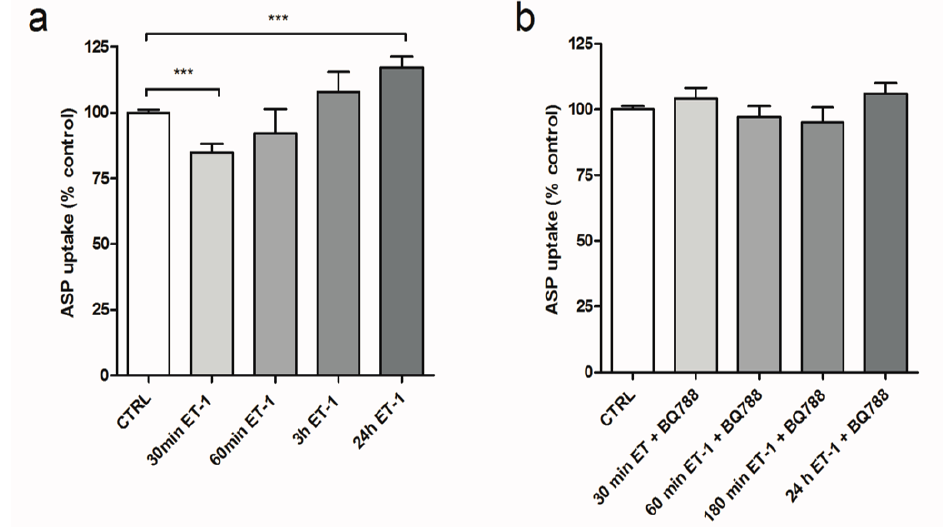
Figure 3. Regulatory effects on OCT mediated ASP + uptake through ET-1 Receptor. Pre- incubation of ciPTEC with 100 µM ET-1 for 30 min up to 24 h inhibits the cellular uptake of 10µM of the fluorescent substrate ASP + . ( a ) The effects of 100 μ M ET-1 on steady state (15 min) ASP + accumulation; ( b ) ASP + accumulation of ciPTEC after pre-incubation with a combination of 100 nM ET-1 with the ET-B receptor inhibitor BQ788 (1 µM),